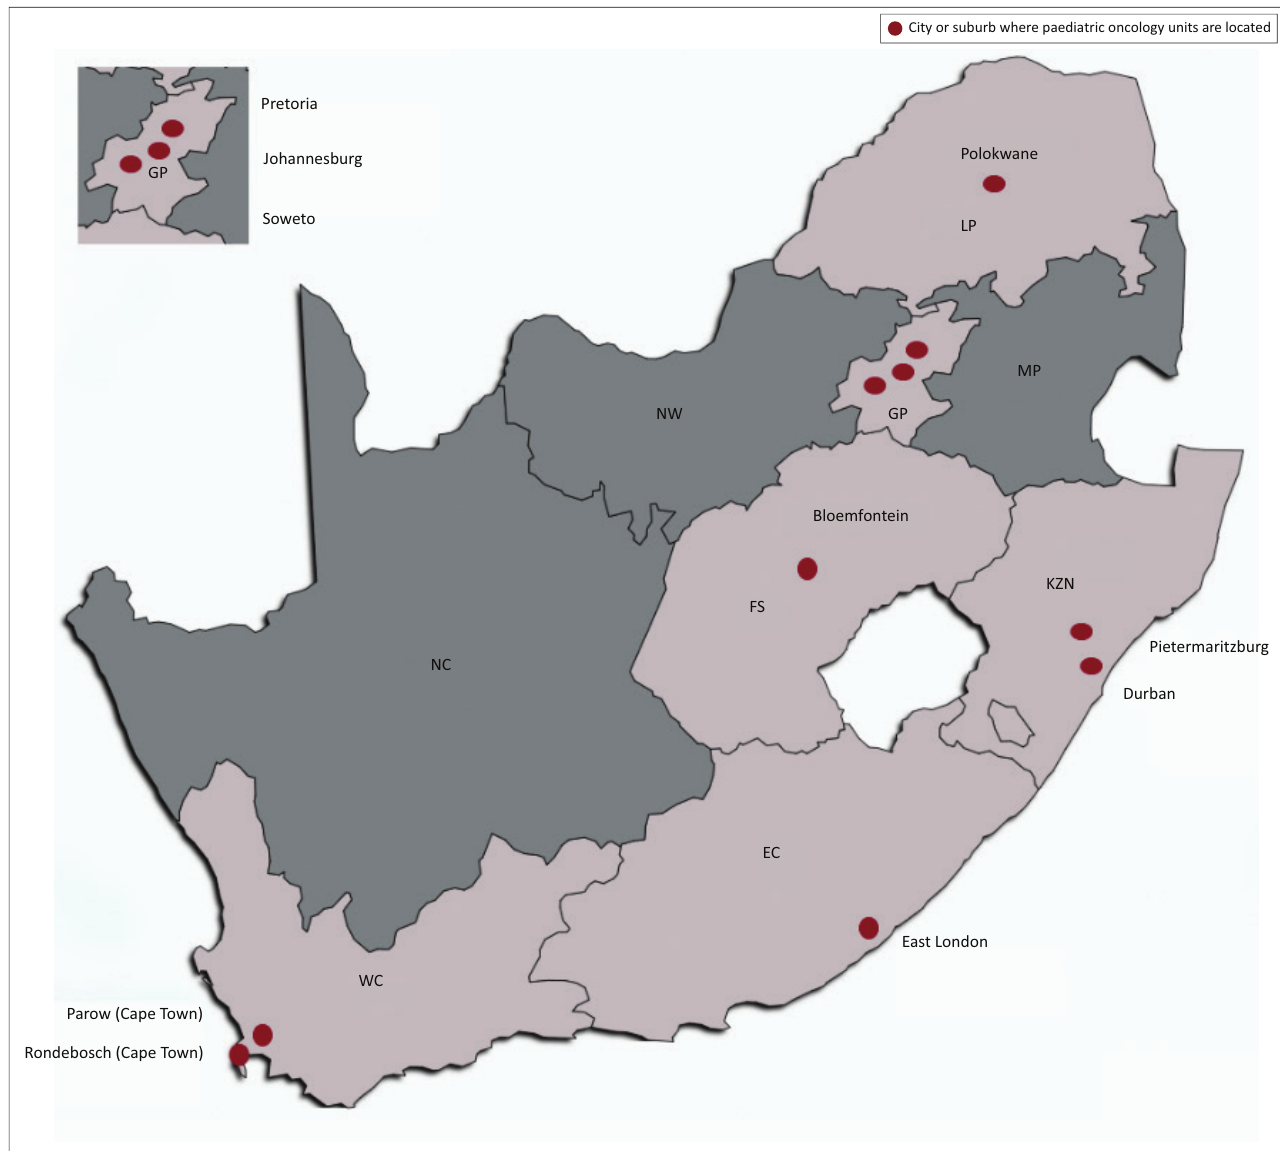
FIGURE 1: The provinces and cities of South Africa with paediatric oncology units from 2000 to